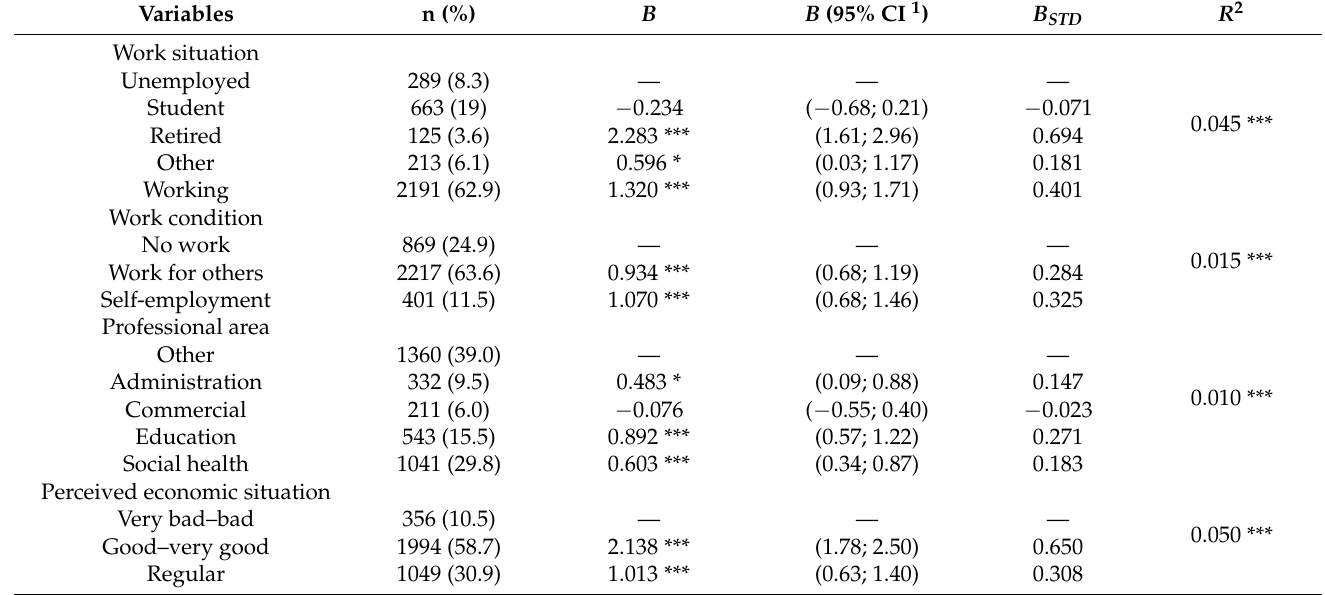
Table 2. Association between work variables and peace and meaning.